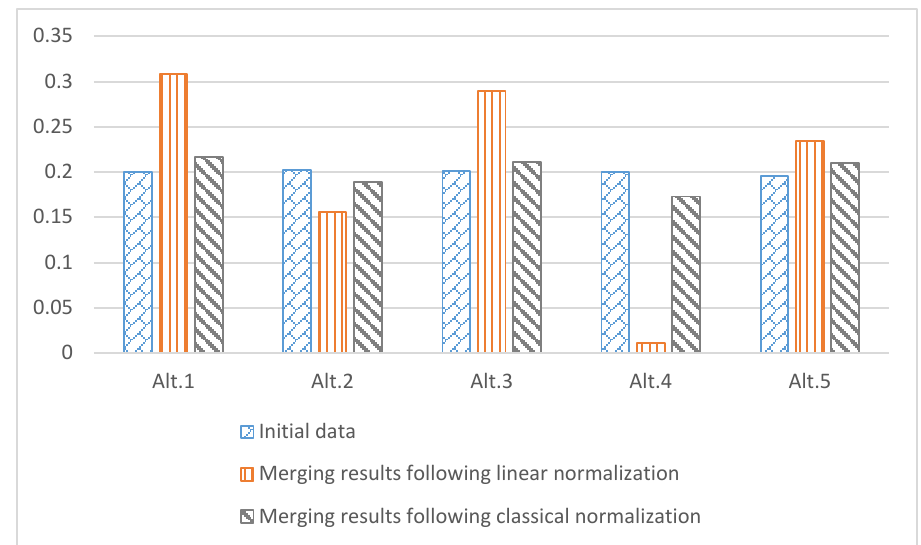
Figure 7. The results of evaluating alternatives, means of numerical values.